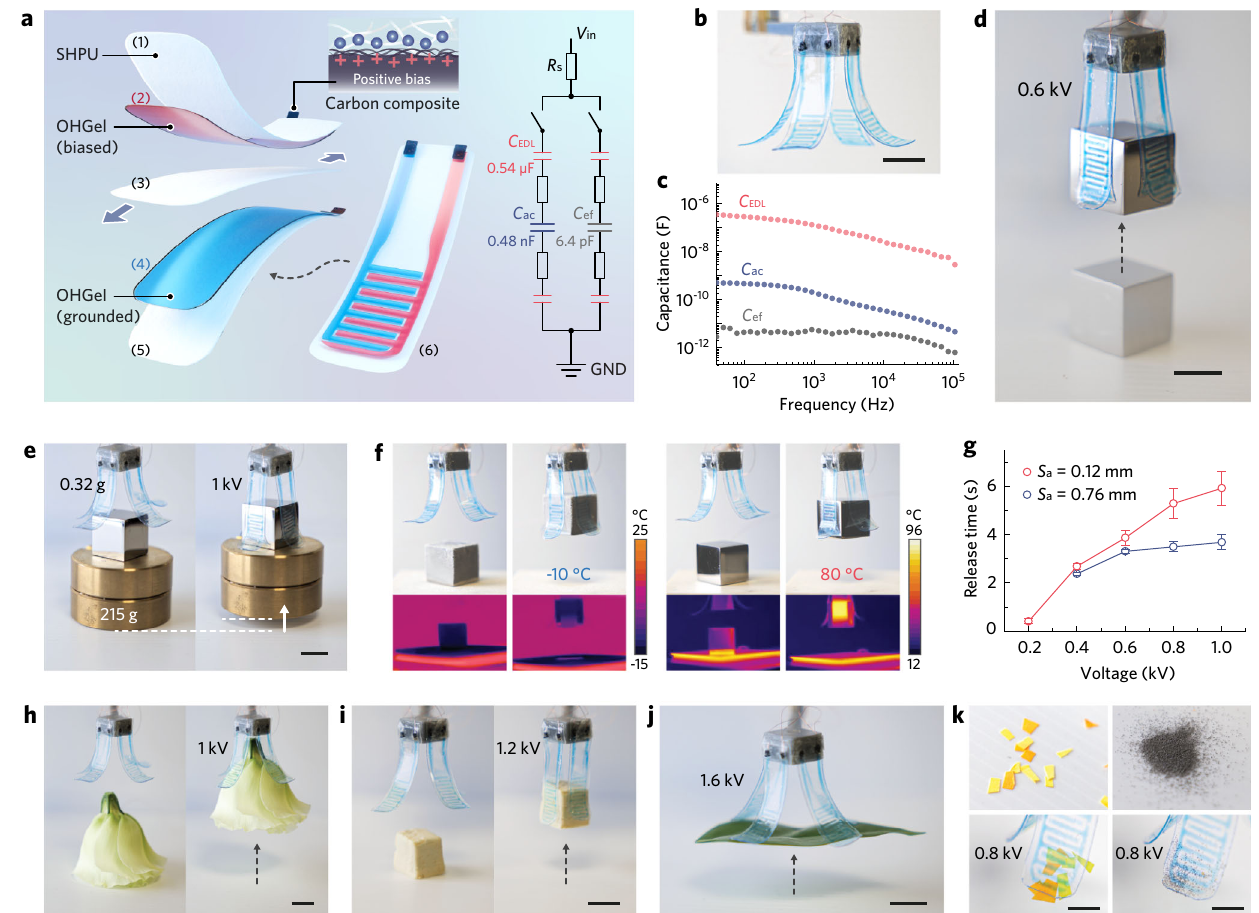
Fig.4|Robustandversatileiontronic-adhesivegripper.a Structuraldesignofan iontronic-adhesive gripping unit consisting of OHGel electrodes and SHPU dielectric layers (left).In the DEA module, a pair ofparallel-plate OHGelelectrodes (2, 4) are separated by a prestretched SHPU membrane (3), then encapsulated by passive SHPU layers (1, 5) on both sides. The thickness of top (1), middle (3, pre- stretched), and bottom (5) SHPU layer is 60 μ m, 60 μ m, and 80 μ m, respectively. The end effector module comprising interdigitated OHGel electrodes and a SHPU contact layer (6, thickness = 60 μ m) isfurther attached below layer (5) to form the gripping unit. The inset diagram represents the equivalent circuit of the gripping unit,where R s denotestheseriesresistanceinducedbywiring,andthenon-labelled resistors denote the ionic resistance of OHGel electrodes. b Photograph of an iontronic-adhesivesoftgripperatrest.Scalebar,10mm. c Capacitanceof C EDL , C ac ,